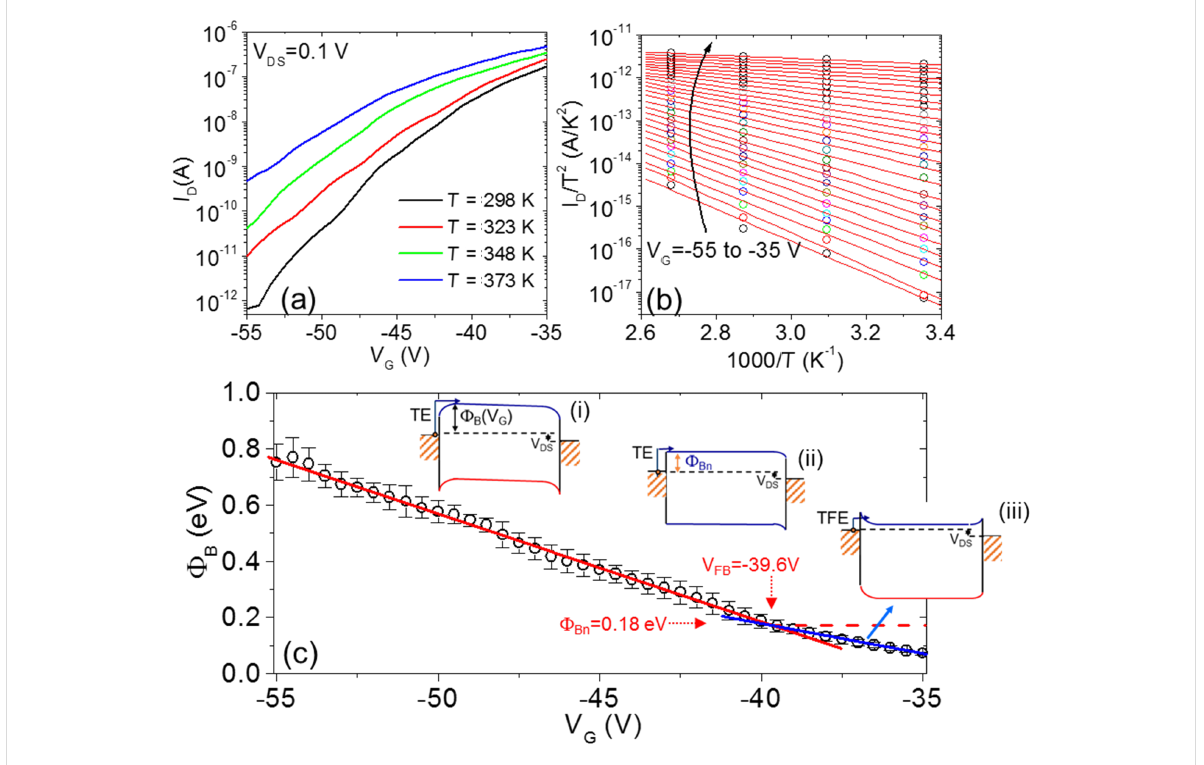
Figure 3: (a) Semilog scale plot of the transfer characteristics ( I D − V G ) in the subthreshold regime at different temperatures ranging from 298 to 373 K. (b) Arrhenius plot of I D / T 2 vs 1000/ T for each gate bias. (c) Effective SBH Φ B as a function of V G . In the inserts, schematic band diagrams are given for the transistor operation in different regimes: depletion (i), flat band voltage (ii) and accumulation